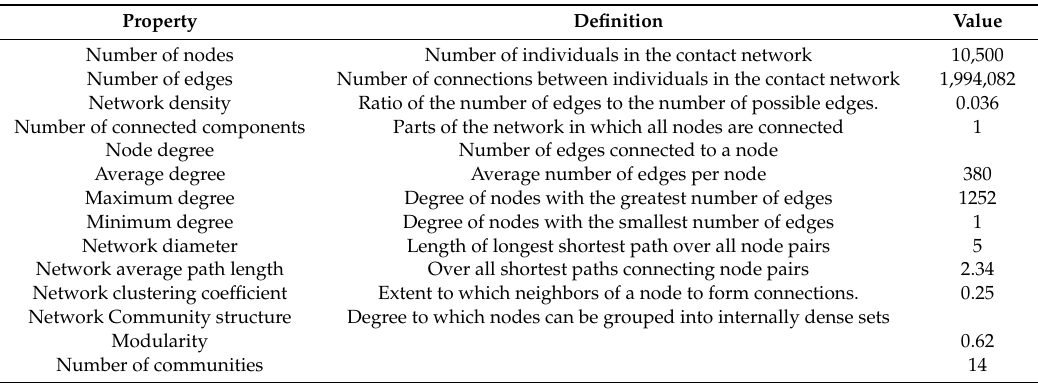
Table 1. Contact network